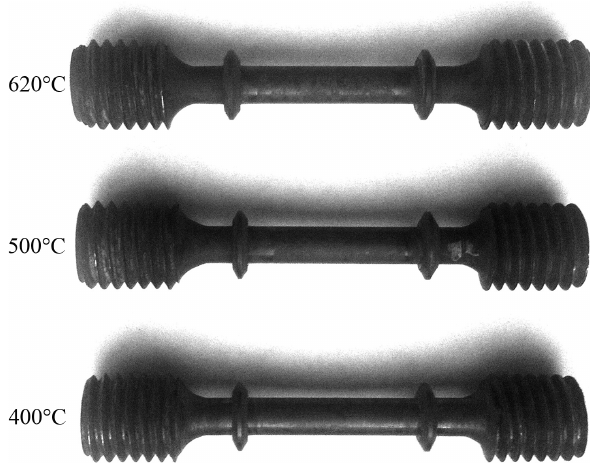
Figure 3: Specimens after stress relaxation experiments.